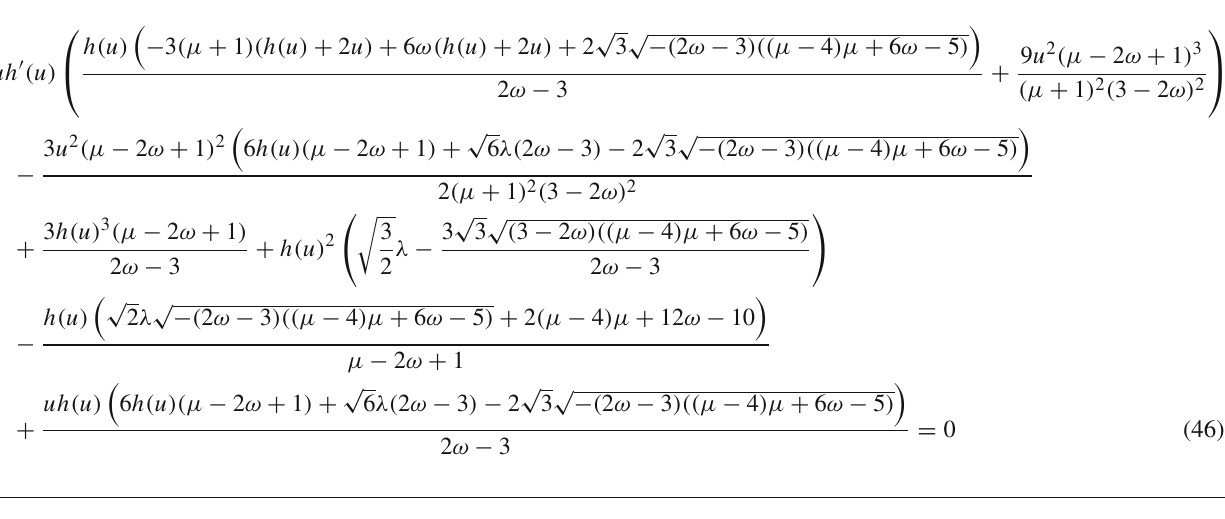
(cid:10) (cid:9) √ + y ( u , v) 2 + x ( u ) + 6